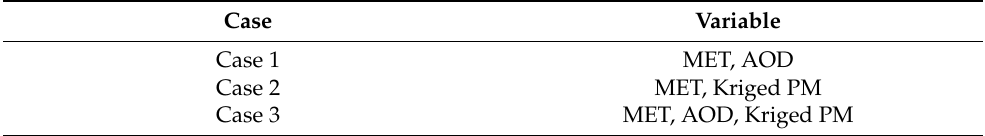
Table 1. Variations of inputs tested to improve spatial